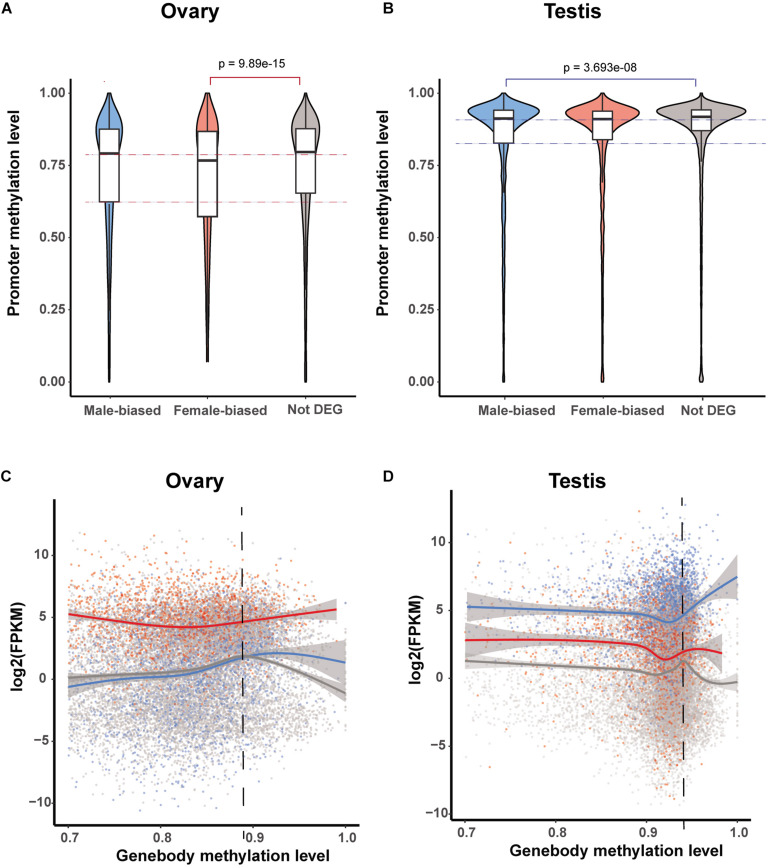
Methylation patterns of sex-biased differentially expressed genes (DEGs). (A,B) Violin plot of methylation levels of male- and female-biased DEGs and non-DEGs among genes in the ovary (A) and testis (B). (C,D) Correlation between gene expression level and gene body methylation level for male- and female-biased DEGs and non-DEGs among genes in the ovary (C) and testis (D).